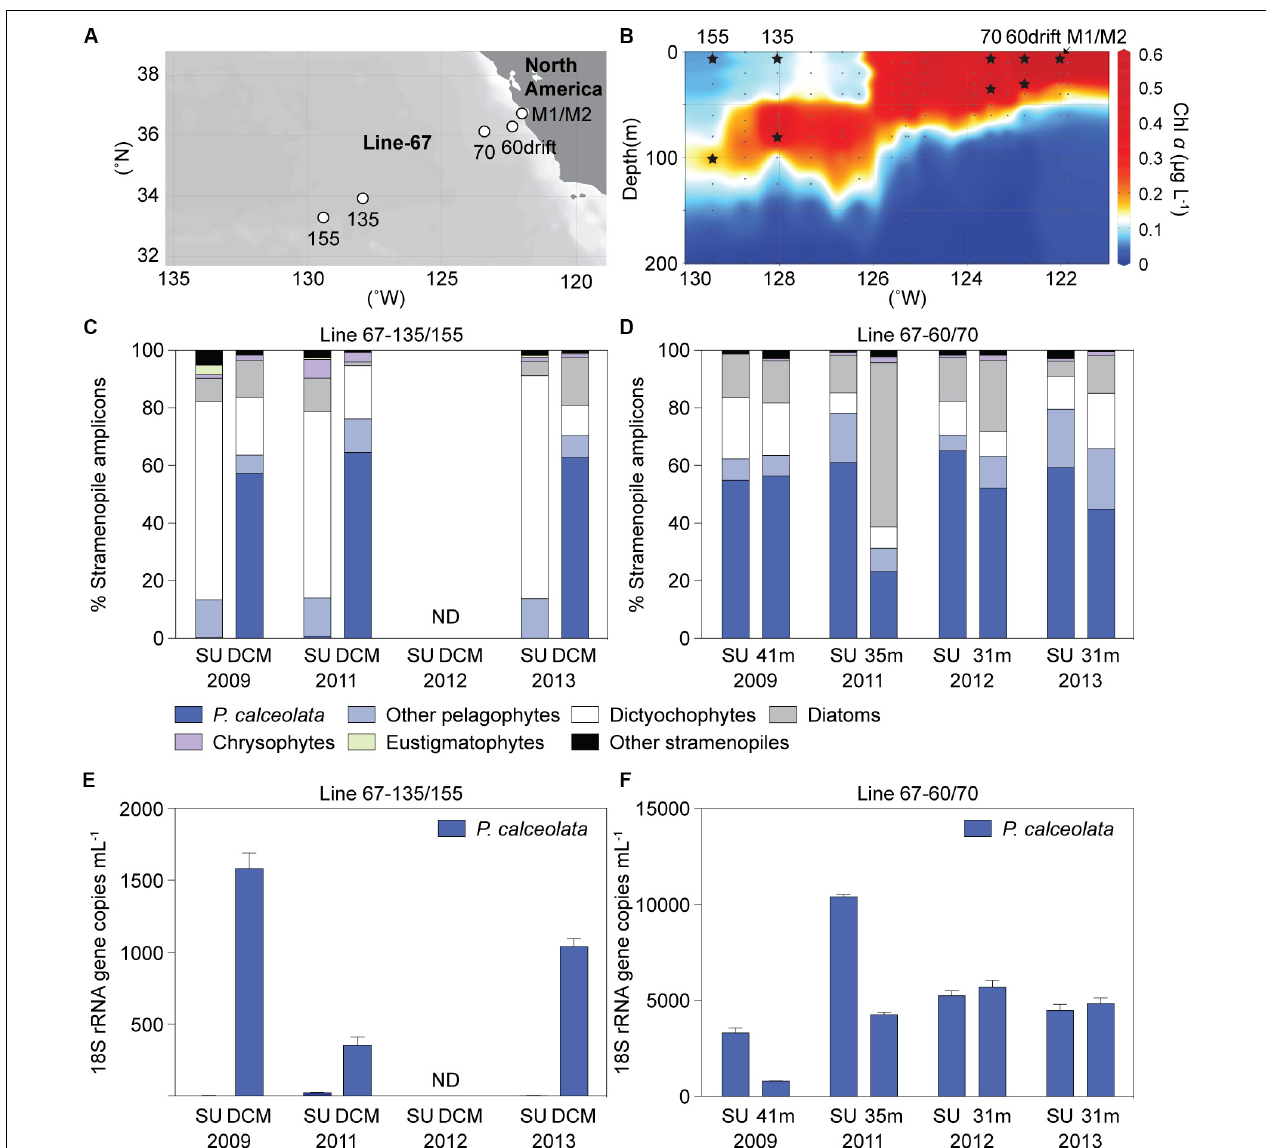
FIGURE 4 | ENP (A) stations and (B) chlorophyll a depth profile in 2009 with sampling for DNA indicated by stars (Stations 67-60drift and 67-70, mesotrophic sites; Stations 67-135 and 67-155, oligotrophic sites). Relative abundance of stramenopile V1-V2 16S rRNA gene amplicons assigned to the Pelagomonas calceolata Clade or other groups in Line-67 samples. (C) Taxon distributions at sites with well stratified water columns where nitrate was 0.02 and 0.08 µ M (plus 1 sample < 30 nM detection limit) at the surface and 0.05 to 0.3 µ M (0.17 ± 0.13 µ M, n = 3) in the deep chlorophyll maximum (DCM). (D) Distributions in surface (SU, 2–14 m) or near the base of the photic zone (31-41 m) at mesotrophic sites. (E,F) P. calceolata 18S rRNA gene copies ml − 1 enumerated by qPCR in the same samples as analyzed for panels C, D. Note the different scale on the y -axis in (E) and (F) . ND: no data. Error bars represent the standard deviation of three technical